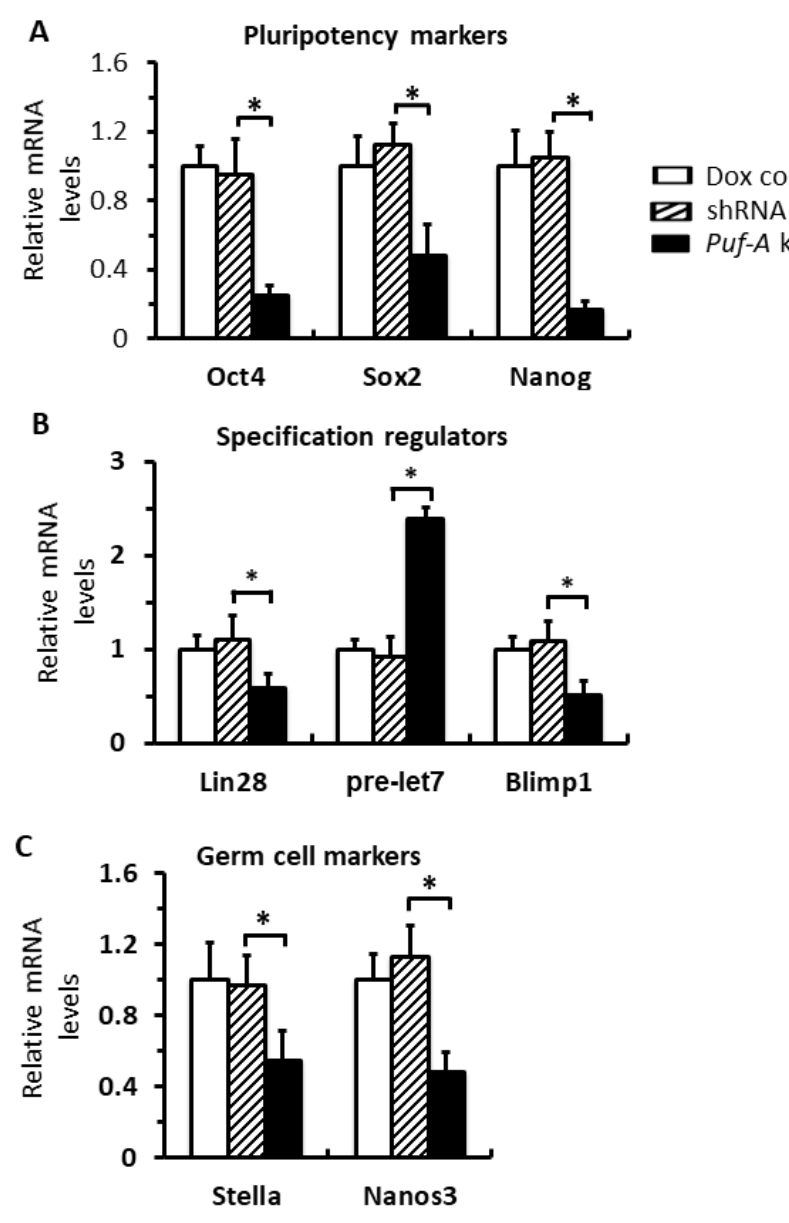
Figure 7. Puf-A protects germ cell fate during early gonad development. qRT-PCR analysis for the PGCs from E10.5 embryos. In Puf-A knockdown PGCs, the expression of genes associated with ( A ) pluripotency markers ( Oct4 , Sox2 , and Nanog ), ( B ) specification regulators ( Lin28 and Blimp1 ), and ( C ) germ cell markers ( Stella and Nanos3 ) was significantly decreased. However, pre-let-7 , the let-7 precursor, which is repressed by Lin28, was up-regulated upon Puf-A knockdown. GAPDH was used as internal control, and Dox control was as also the control. Error bars represent SD with n = 3, and * p < 0.05.